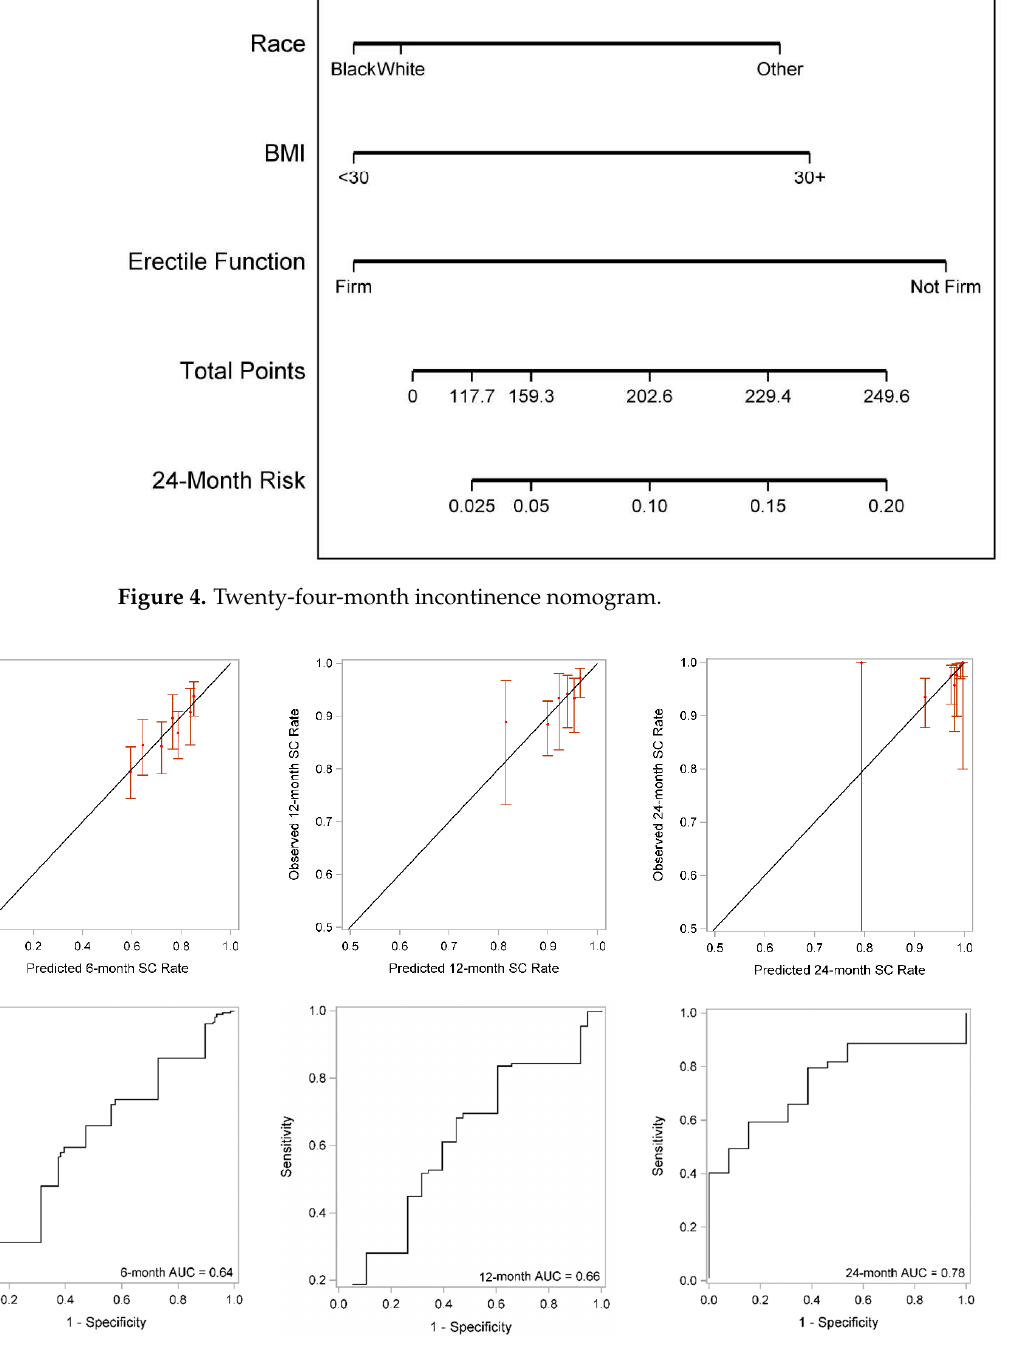
Figure 5. Calibration plots ( upper panels ) and receiver operating curves (ROC) ( lower panels ) that showed initial model performance at 6, 12, and 24 months. SC = social continence; AUC = area under the curve.